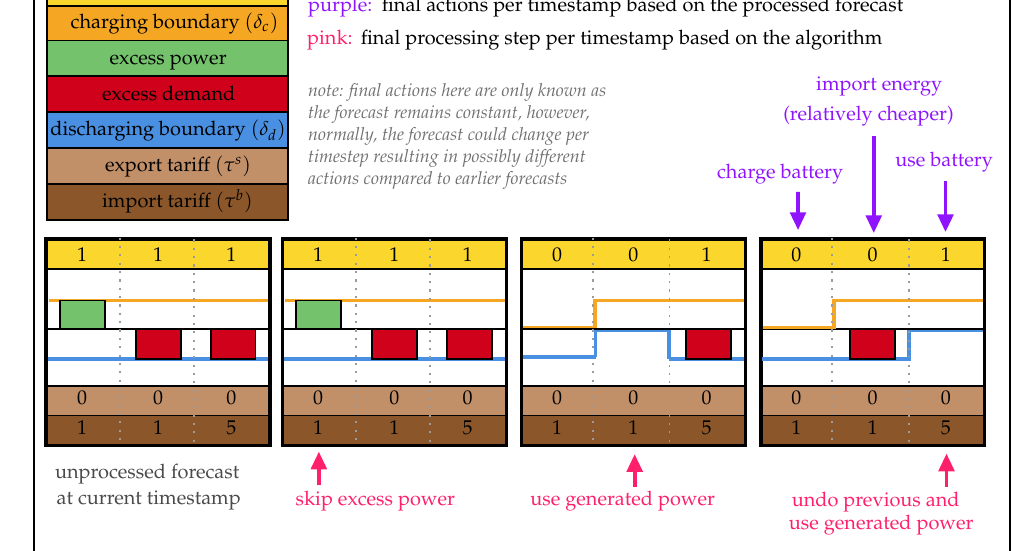
Figure 6. Systematic walkthrough of the proposed smart battery scheduling algorithm for an example scenario with expensive future excess demand. The energy is imported at the lowest import tariff while discharging the battery during the highest import